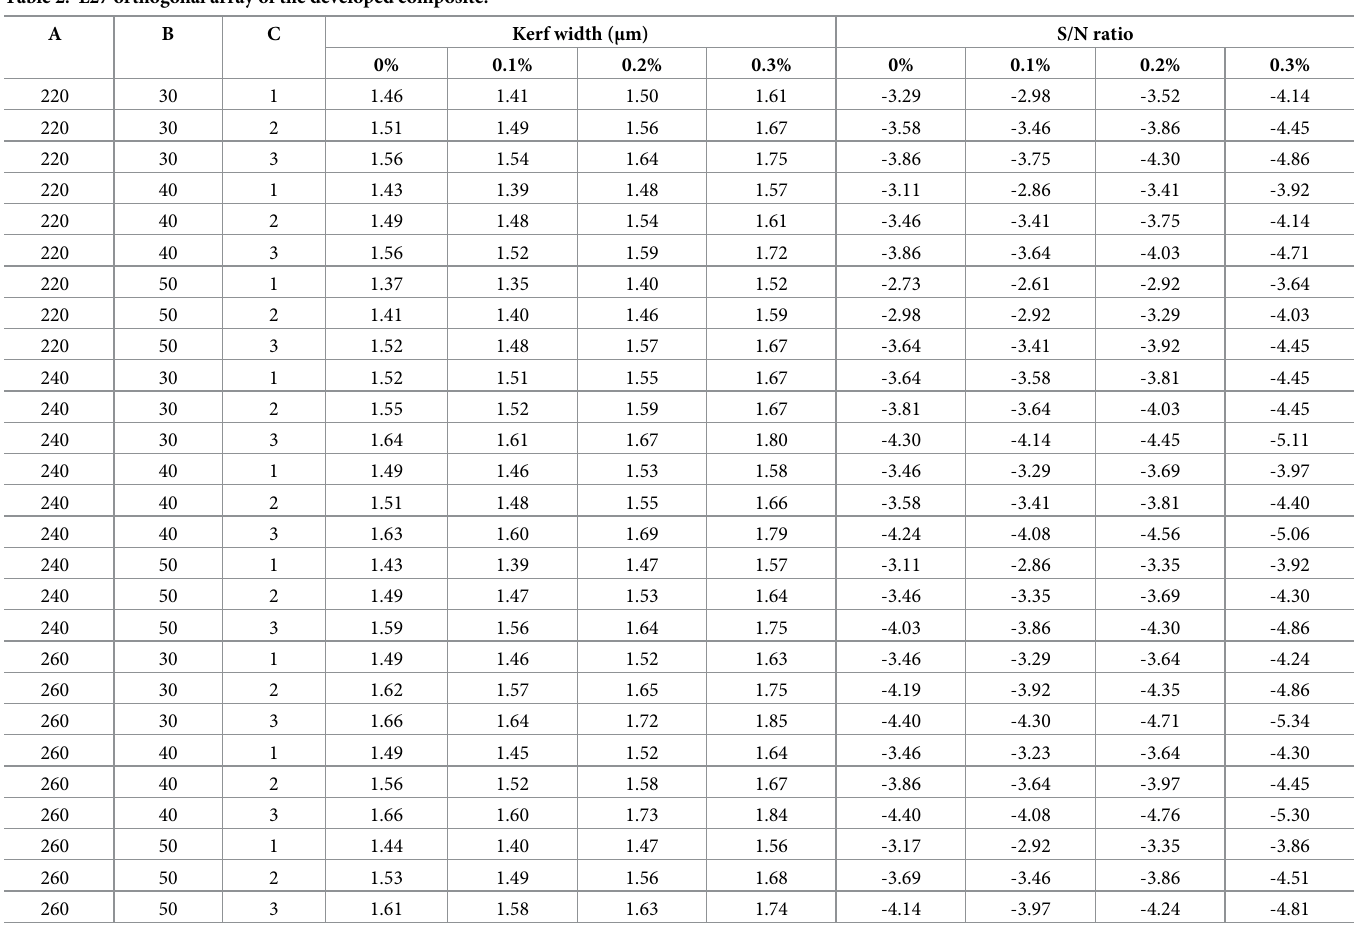
Table 2. L27 orthogonal array of the developed